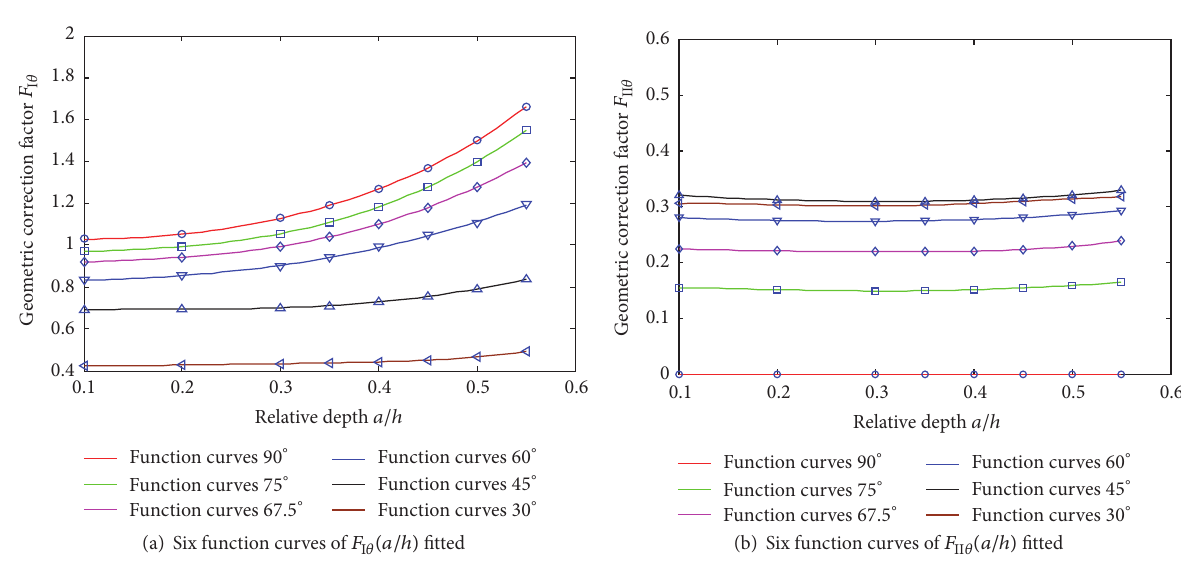
(b) Six function curves of 𝐹 ΙΙ𝜃 (𝑎/ℎ) fitted Figure 5: 12 function curves fitted from 12 geometric correction factor